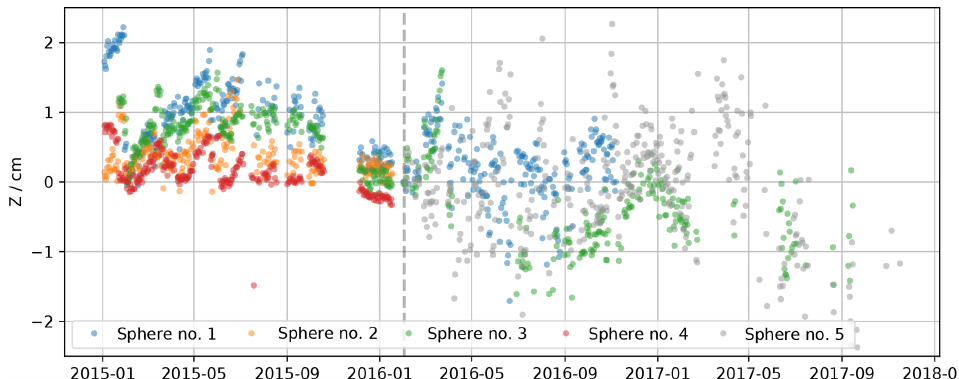
Figure 2. Evolution of the elevation of five calibration spheres set up in the scanned area at the beginning of period 1. The gray dashed line shows the beginning of period